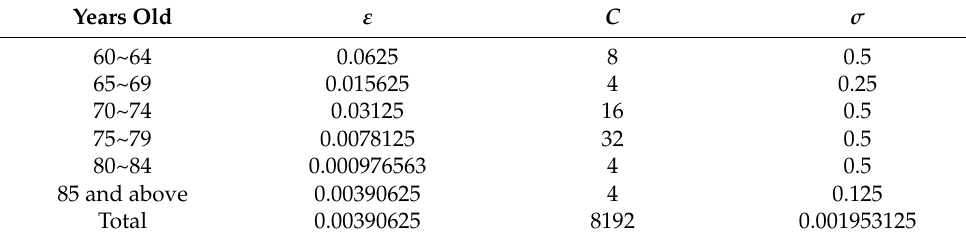
Table 2. Parameter settings in PSOSVR.